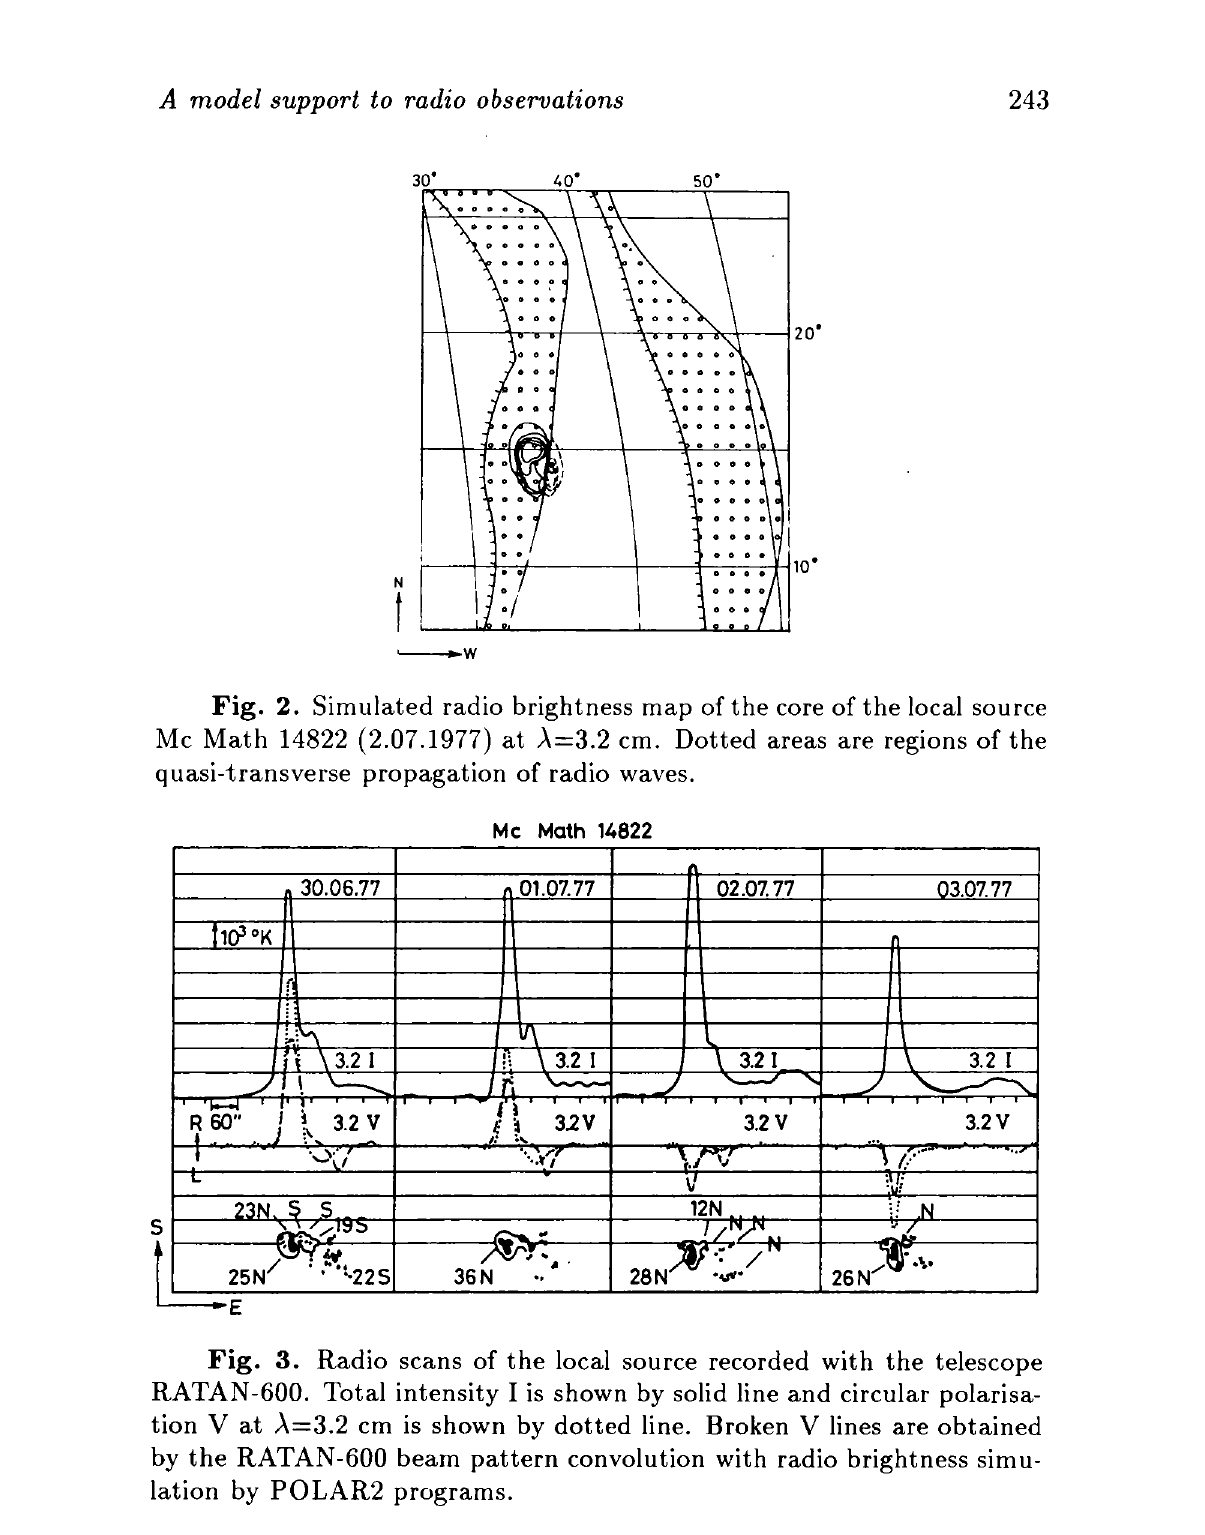
Fig. 2. Simulated radio brightness map of the core of the local source Mc Math 14822 (2.07.1977) at A=3.2 cm. Dotted areas are regions of the quasi-transverse propagation of radio waves.